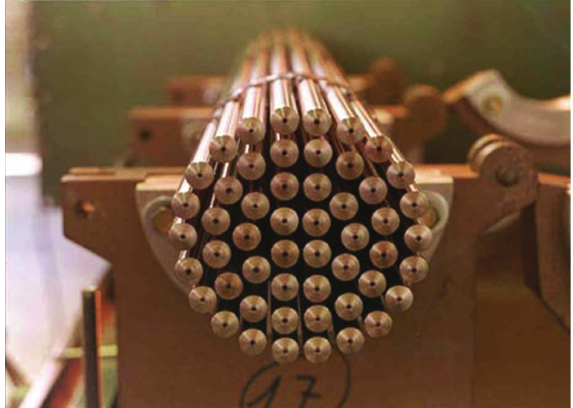
Figure 4: CARA rod bundle.